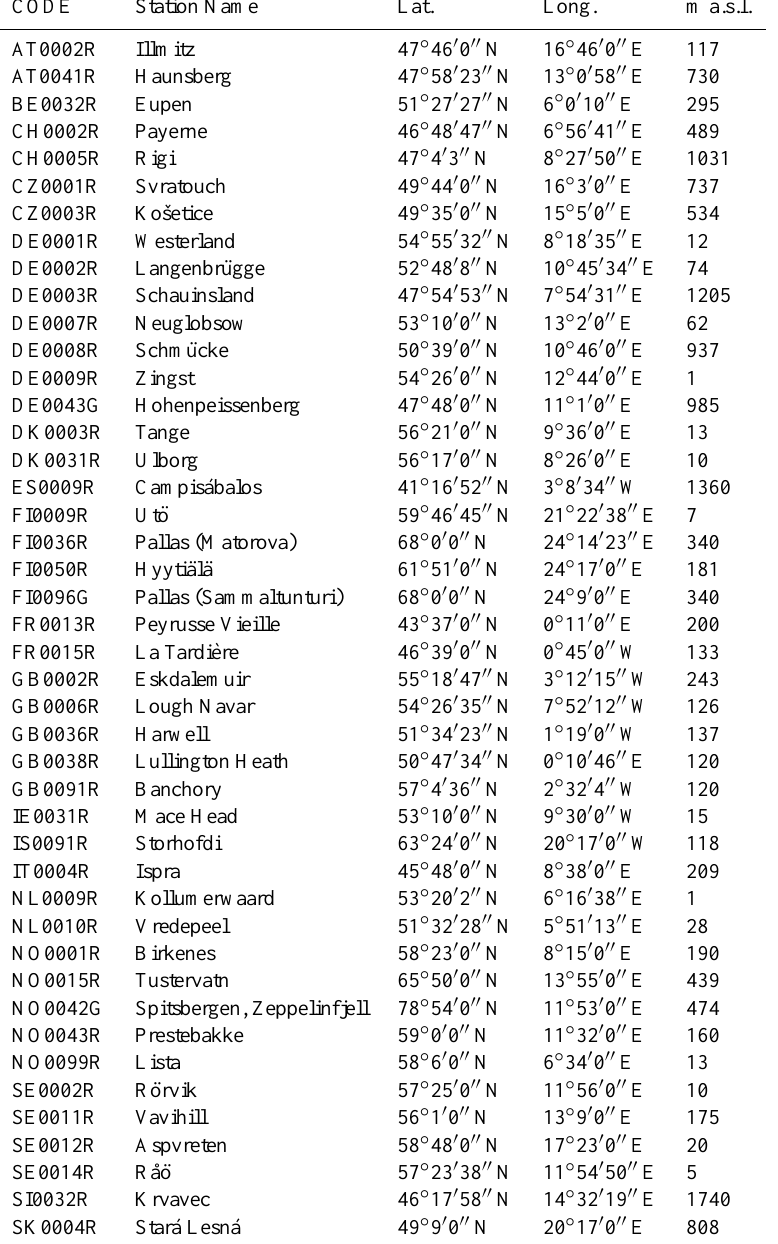
Table A1. List of stations included in the trend analysis (for information about other sites presented on maps we refer to